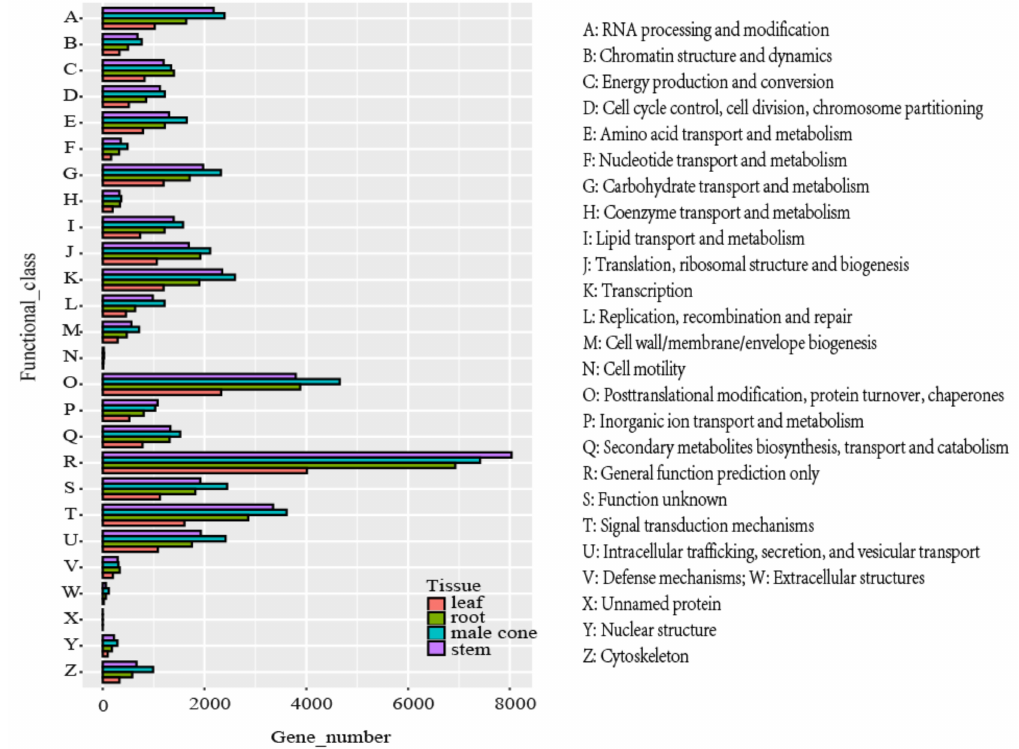
Figure 1. Eukaryotic ortholog group (KOG) classification of